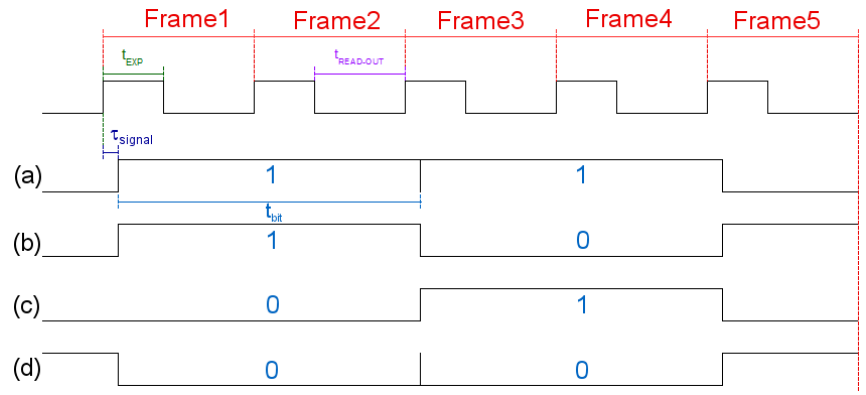
Figure 18. Possible transmitted signals. ( a ) Transmitting bit "1" after bit "1", ( b ) Transmitting bit "0" after bit "1", ( c ) Transmitting bit "1" after bit "0", ( d ) Transmitting bit "0" after bit "0" Another simulation was also held. In this case, for each projected distance, the corresponding pixels SIR ( Pix S / Pix I ) was calculated using Equation (4) with the NPSIR values obtained in the previous experiment and the parameters of the simulated camera and emitters. Finally, the BER was calculated in function of the SIR. As shown in Figure 19, the sensors on the table (S1 and S3) had a wider disk representation than the sensor over the autonomous robot (S2) due to the height’s difference.